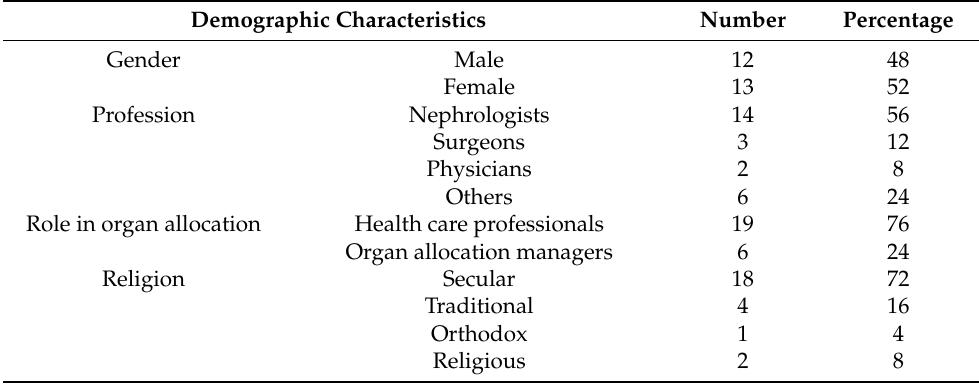
Table 1. The demographic